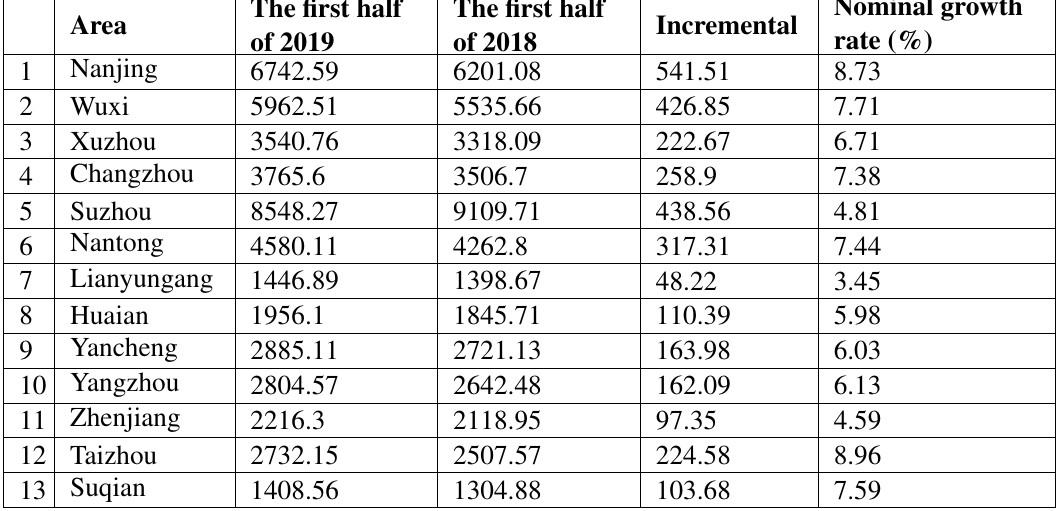
Table 2 Comparison of GDP increment in the first half of 2018 and the first half of 2019 (100 million yuan) Area